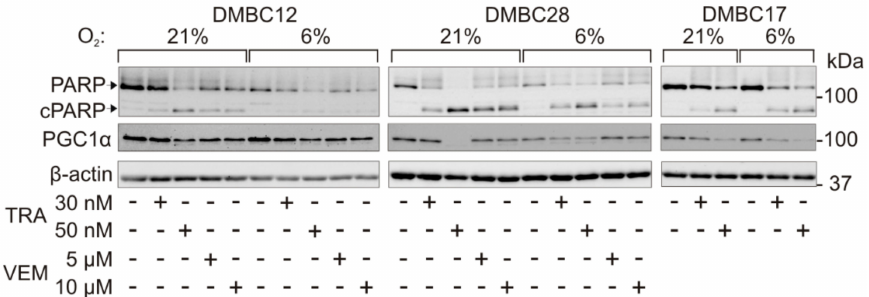
Figure 6. Changes in the protein level of PGC1 α during drug-induced apoptosis. Protein levels of PARP and PGC1 α after 44 h of treatment with vemurafenib (VEM) and trametinib (TRA) at indicated concentrations in normoxia (6% O 2 ) and hyperoxia (21% O 2 ) were assessed by western blotting with representative images shown ( n = 3). Upper and lower arrows indicate full-length and cleaved PARP (cPARP), respectively. β -actin was used as a loading control.